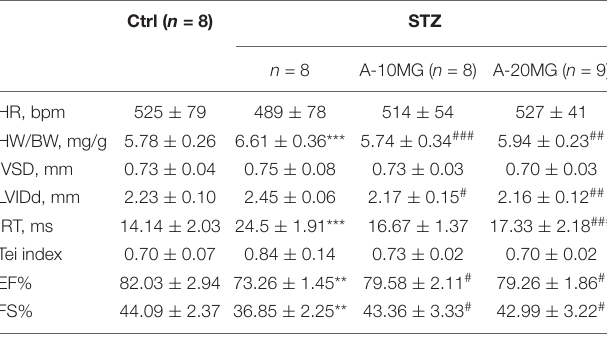
TABLE 2 | Biometric and echocardiographic parameters of the C57BL/6 experimental